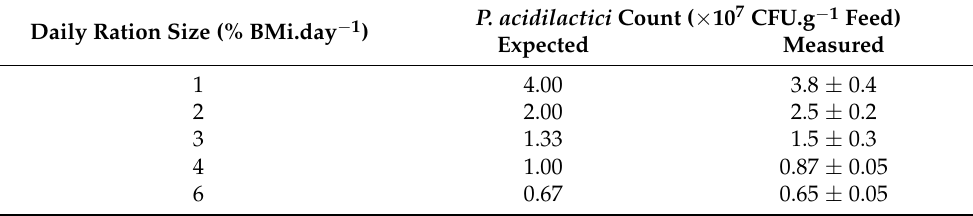
Table 2. Expected and measured probiotic concentration ( Pediococcus acidilactici ) in the probiotic diet prepared at different concentration for each ration size in order to achieve a daily probiotic intake of 4 × 10 8 CFU.kg − 1 shrimp. Mean ± SD. Measured count was always within the acceptable range (<0.5 log difference between expected and measured